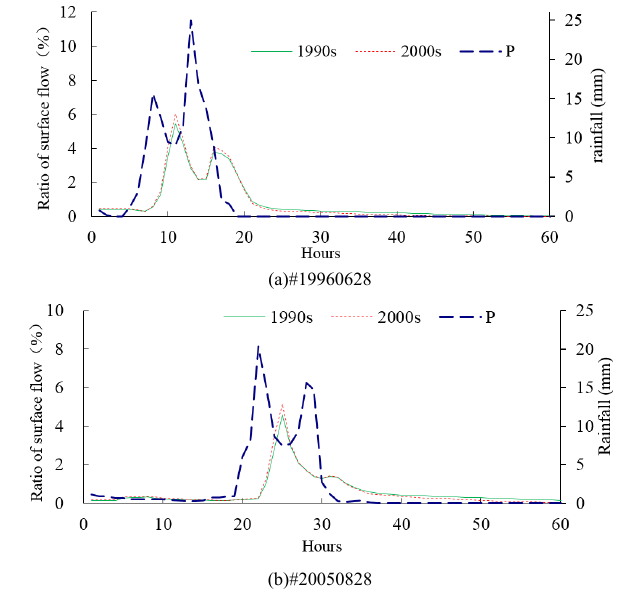
Figure 4. Temporal variations of the percentage of surface runoff